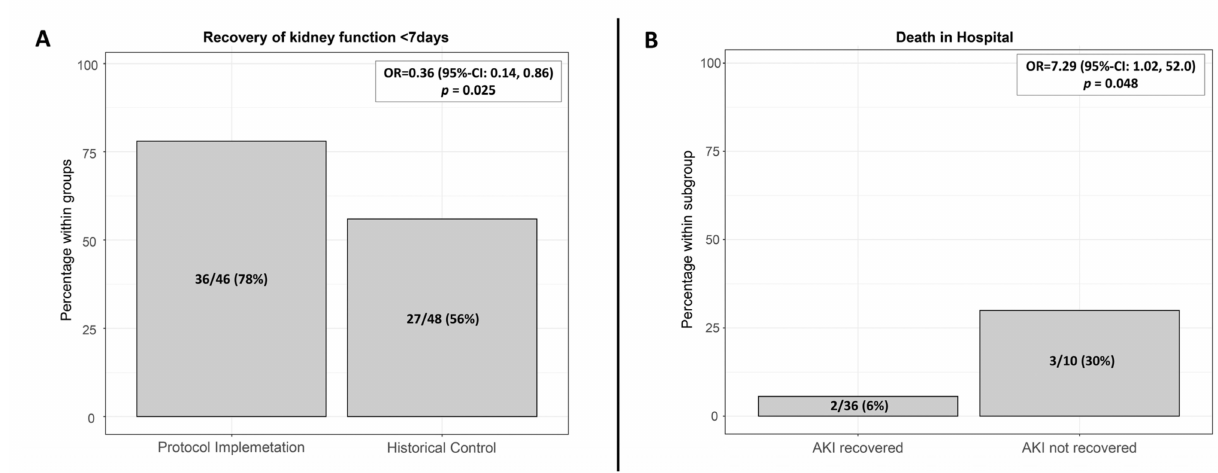
Figure 3. ( A ) Recovery of renal function within the first 7 days after surgery in the historical control group and after protocol implementation, p = 0.025 (Chi-Quadrat-Test); ( B ) Protocol implementation cohort: In-hospital mortality of patients with complete AKI recovery within the first 7 days after surgery (2/36), of patients without recovery (3/10), p = 0.048. AKI: Acute kidney